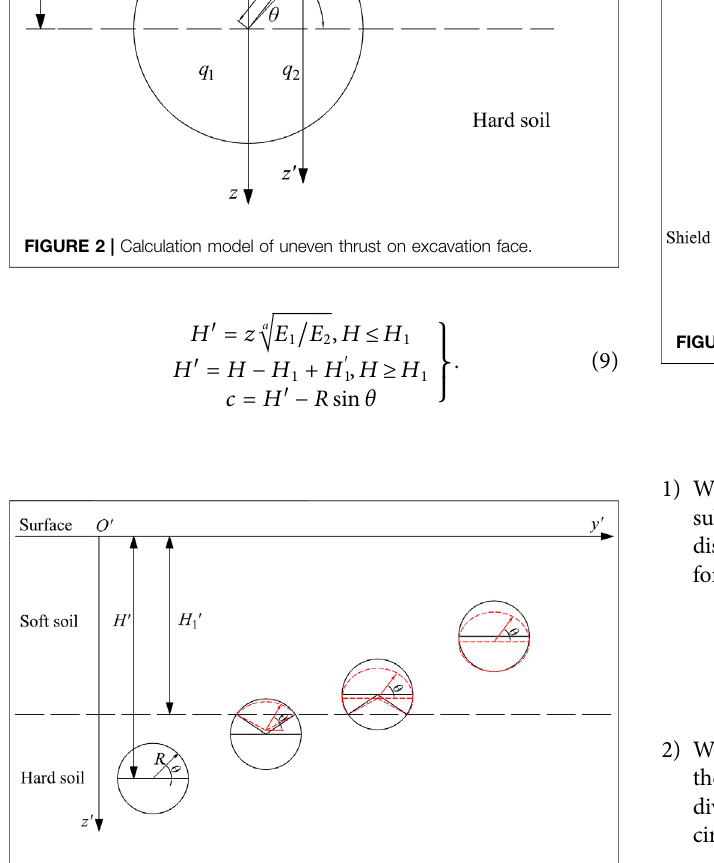
FIGURE 3 | Shield machine location in different soil conditions.